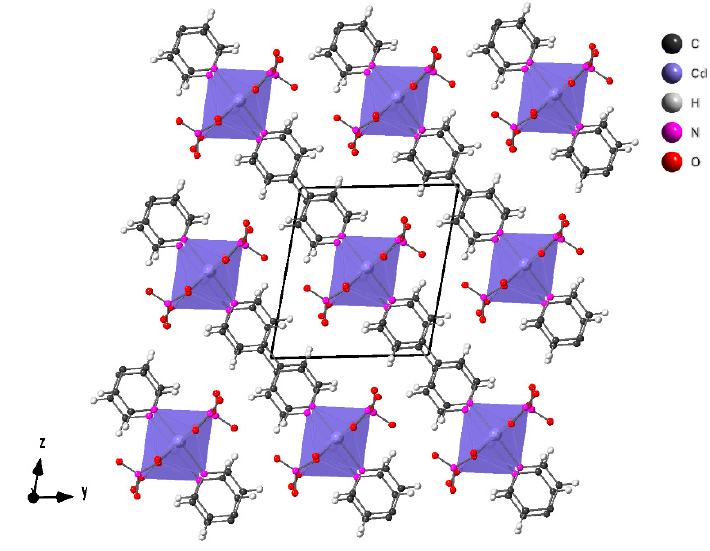
Figure 3. Crystal structure representation of compound 2 .